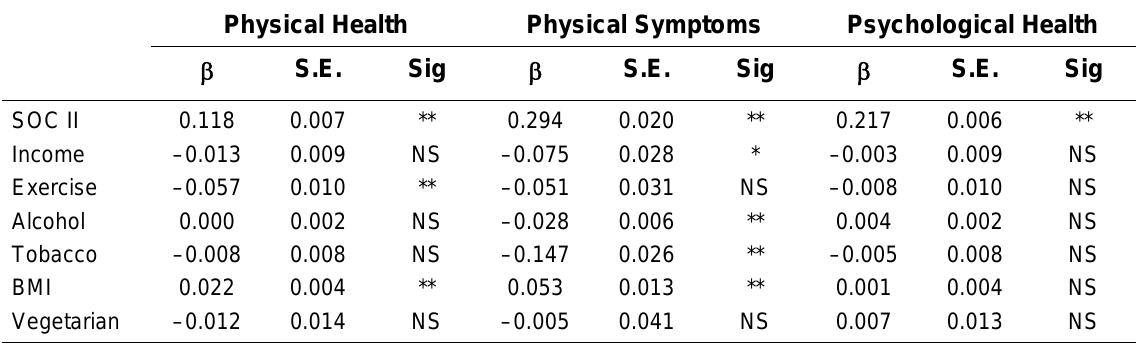
Model 2 (Life Style Variables), Linear Regression Analysis with Health as the Dependent